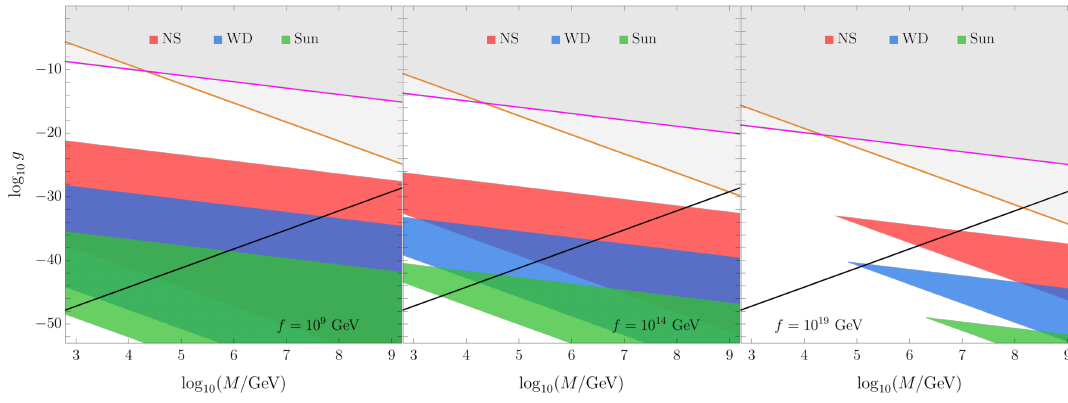
Figure 3 . ( M, g ) -regions excluded by the formation and escape of a non-QCD relaxion bubble induced by neutron stars (red), white dwarfs (blue), and the Sun (green), in the case of shallow minima, δ 2 (cid:28) 1 or equivalently Λ ’ Λ , and for f = 10 9 , 10 14 , 10 19 GeV (left, middle, right R C . 4 πv 2 (orange line) and pannel). The grey, shaded region is excluded by the requirements Λ 2 C ∆ h 2 < v 2 (magenta line), while the region of parameter space preferred by relaxation during inflation lies above the diagonal black line. Note that the latter line depends on a model-dependent period of dynamical evolution, which our constraints are independent of. Recall that g = Λ 4 /M 3 f and we R have taken ‘ ∗ = 1 in eq.